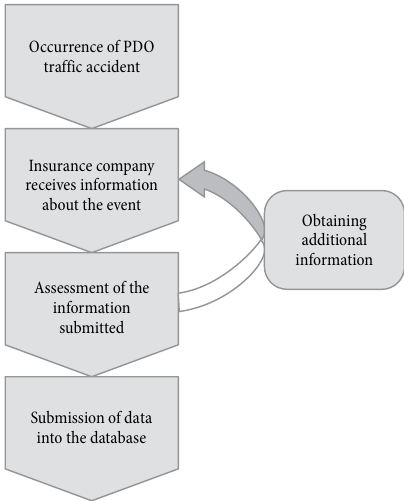
Fig. 2. Data collecting process in case of MTPL